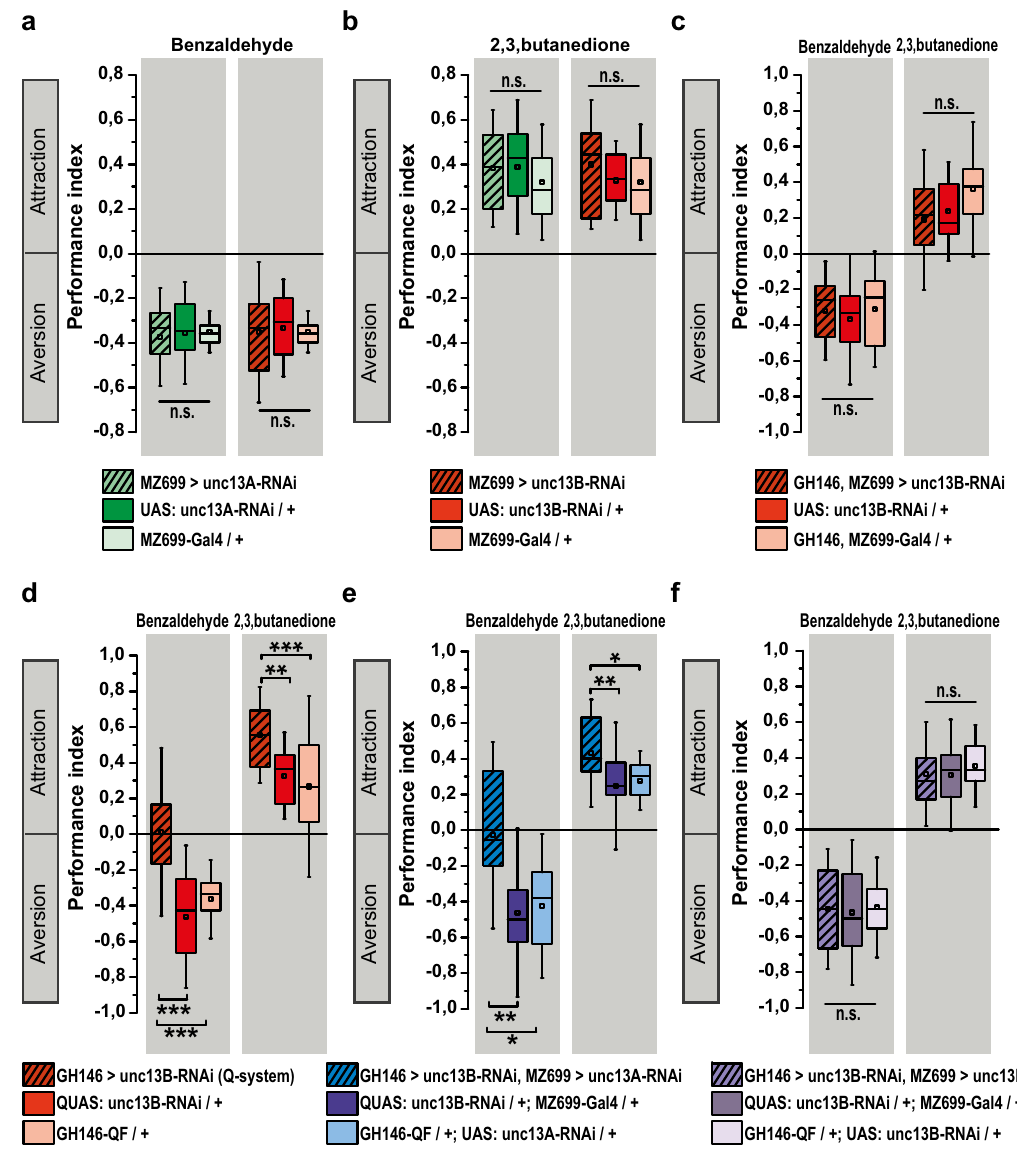
Fig. 6 Unc13B-mediated transmission components in ePNs and iPNs operate antagonistically. a , b unc13A knockdown or unc13B knockdown in iPNs using MZ699-Gal4 driver line has no signi fi cant effect in performance index of animals toward aversive (benzaldehyde n = 12 – 17) and appetitive (2, 3- butanedione, n = 13 – 20) odors. c Knockdown of unc13B in both ePNs and iPNs using combined driver lines, GH146-Gal4, MZ699-Gal4, eliminates the behavioral effect of unc13B knockdown in ePNs. No signi fi cant difference in performance index of animals with ePN-iPN unc13B knockdown toward appetitive and aversive odors in comparison to the control groups was observed (benzaldehyde n = 14 – 16, 2, 3-butanedione, n = 17 – 18). d Knockdown of unc13B in ePNs using QUAS/QF system leads to reduced aversion toward aversive odor (benzaldehyde, n = 21 – 23) and increased attraction toward appetitive odor (2, 3-butanedione, n = 21 – 26). e Simultaneous knockdown of unc13A in iPNs using UAS/Gal4 system and knockdown of unc13B in ePNs using QUAS/QF leads to the signi fi cant reduction in aversion toward aversive odor (benzaldehyde, n = 10 – 12) and increased attraction toward appetitive odor (2, 3-butanedione, n = 22 – 26). f Knockdown of unc13B in iPNs using UAS/Gal4 system and knockdown of unc13B in ePNs using QUAS/QF eliminate binary systems) toward appetitive and aversive ( n = 12 – 14) odors in comparison with the control groups was observed. All p values were calculated via one-way ANOVA with the Bonferroni multiple comparison post hoc test (n.s., not signi fi cant ( p > 0.05), * p ≤ 0.05, ** p ≤ 0.01, *** p ≤ 0.001). Box plots indicate means (black squares), medians (middle lines), 25th and 75th percentile ranges (boxes), and SD ranges (whiskers). Source data including the exact sample sizes and the p values are provided as a Source Data fi le. See also Supplementary Fig. 12, GABAergic signaling from iPNs and cholinergic signaling from ePNs to overlapping populations of higher-order LH neurons.